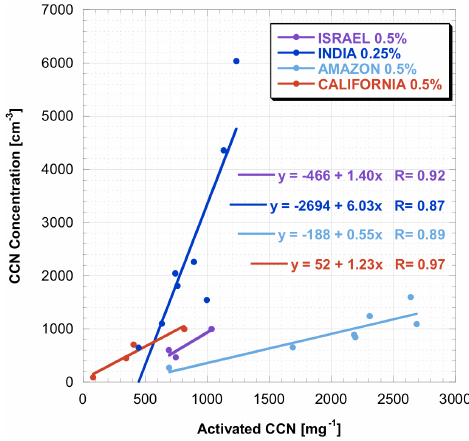
Fig. 9. CCN concentration vs. N a . Each data point denote a full Fig. 8. Comparison of N a , which is based on extreme inho- init vertical profile in a deep convective cloud. The CCN concentra- mogeneous mixing assumption, with the final derived N a , that as- tions were measured below cloud base (with DMT CCN counters) sumes homogeneous mixing with pre-moistened air. The color- at different super-saturations as indicated in the legend. The color- coding is the same as in Fig. 7, with added data from flights within coding is similar to Figs. 7 and 8 and represents the different field the projects of EUCAARI (European Integrated project on Aerosol campaigns. Notice the fairly strong linear relationship in each field Cloud Climate and Air Quality interactions; Kulmala et al., 2009) campaign separately. The different slopes cannot be fully explained over the Netherlands and the North Sea (in orange) and SUPRECIP by differing updrafts and super-saturations, but rather by the differ- (Suppression of Precipitation Experiment; Rosenfeld et al., 2008b) ent instruments and calibrations over California (in red). Each data point here represents one pro- file. The black linear best-fit and equation show that, on average, N a is smaller than N a by ∼ 30%. It does not appear like there are init significant differences between the different locations, as they fall within the same range of slopes, although the Amazon and Texas data stand out for having generally high and maybe slightly unrea- sonable values of N a , which may be an indication of droplet under- sizing by the cloud droplet probes (see Sect. 3.6).